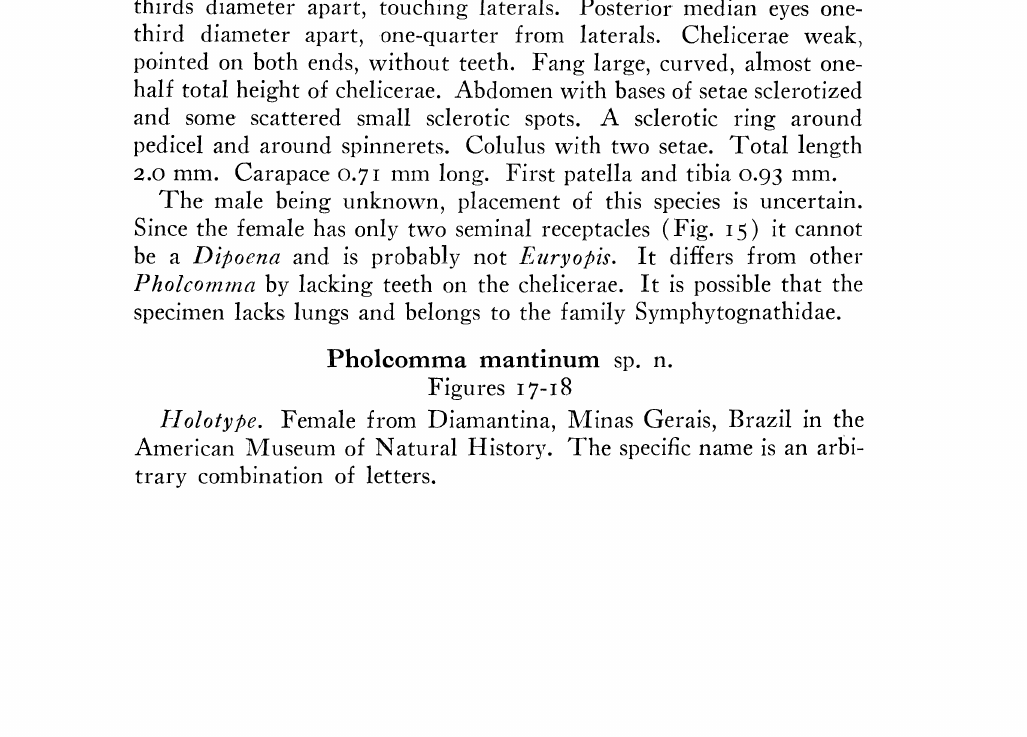
Figs. 15-16. "’Pholcomma" micropunctatum (Mello-Leit,o). 15. Epigynum cleared. 16. Epigynum. Figs. 17-18. "’Pholcomrna" rnantinum sp. n. 17. Epigynum cleared. 18.